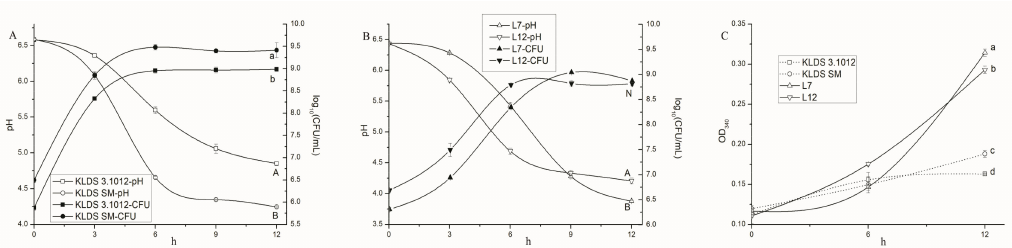
Figure 1. Technological properties of S. thermophilus and Lb. bulgaricus strains in pure culture: ( A ) pH value of milk and viability of S. thermophilus strains KLDS3.1012 and KLDS SM during 12-h fermentation; ( B ) pH value of milk and viability of Lb. bulgaricus strains L7 and L12 during 12-h fermentation; and ( C ) Proteolysis (Optical density, OD340 nm) of four strains of S.